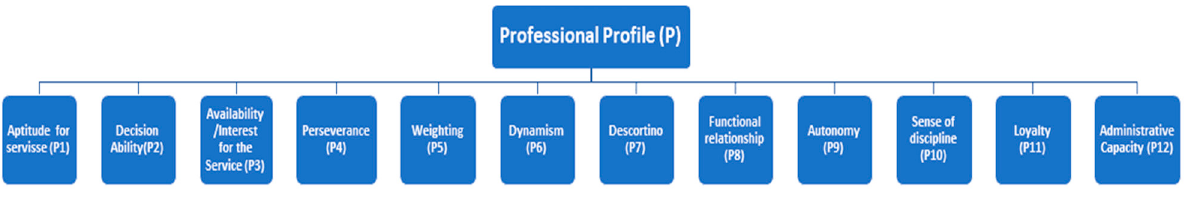
Figure 5. Subcriteria of the Professional Profile criterion.